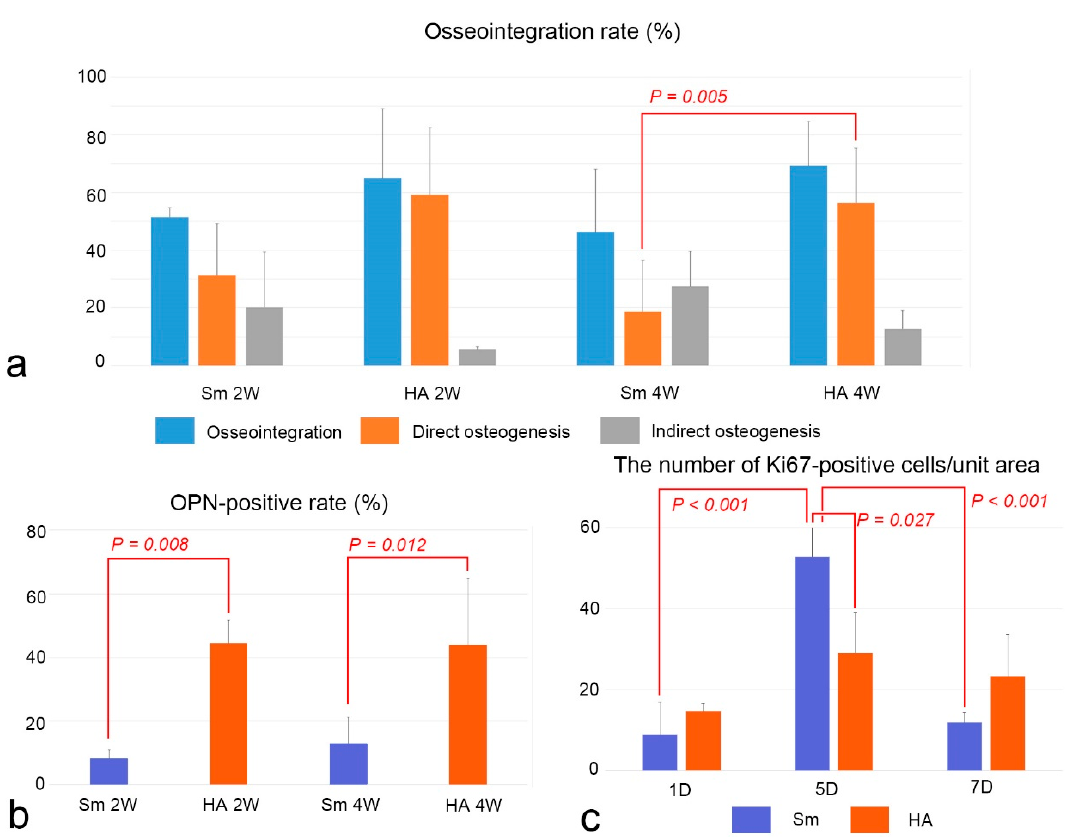
Figure 4. Osseointegration rate ( a ), OPN-positive rate ( b ), and the number of cell proliferation ( c ) in the HA and Sm groups. ( a ) The osseointegration rates between two groups are compared using the two-tailed Student’s t -test. There is a significant difference in direct osteogenesis between the HA and Sm groups at week 4. ( b ) The number of OPN-positive rates between the two groups are compared using the two-tailed Student’s t -test. The OPN-positive rate in the HA group is significantly higher than the Sm group at weeks 2 and 4. ( c ) The number of Ki67-positive cells among different stages after implantation is compared using one-way analysis of variance (ANOVA) followed by the Bonferroni test for multiple comparisons and the number of Ki67-positive cells between two groups are compared using the two-tailed Student’s t -test. Cell proliferative activity peaks at postoperative day 5 in both the HA and Sm groups and is significantly higher in the Sm group than the HA group at day 5. The numbers are the mean + standard deviation